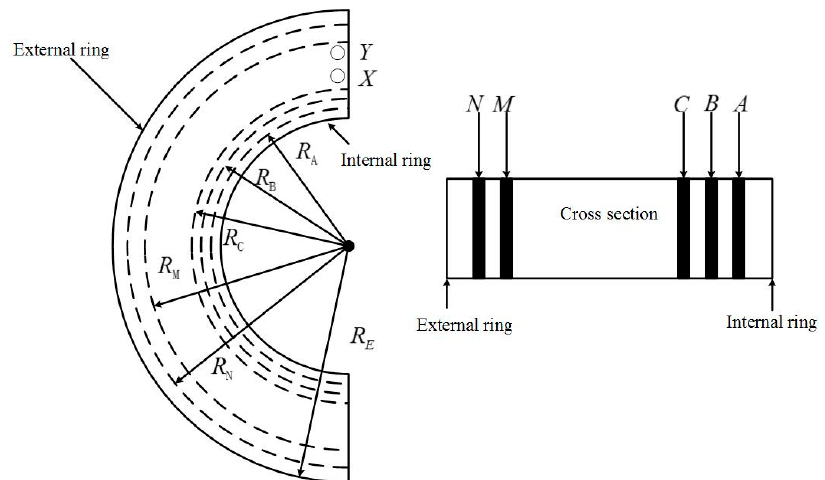
Figure 6. Structure of rows of vias.